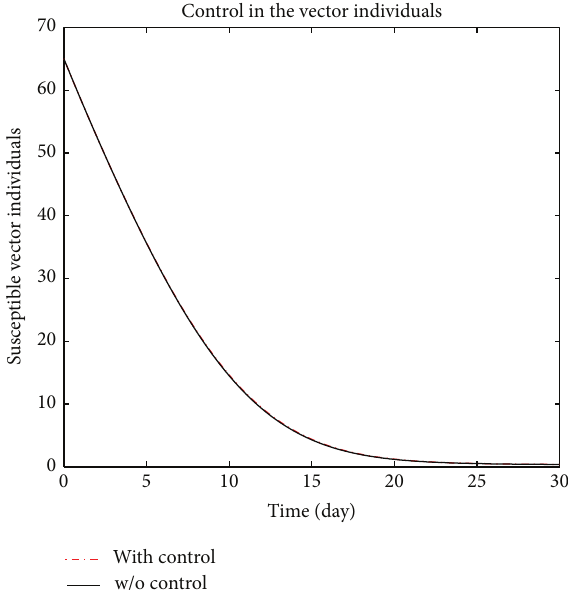
Figure 9: Plot of the number of susceptible hosts with and without control, 𝑢 1 ̸=0 , 𝑢 2 = 0 .